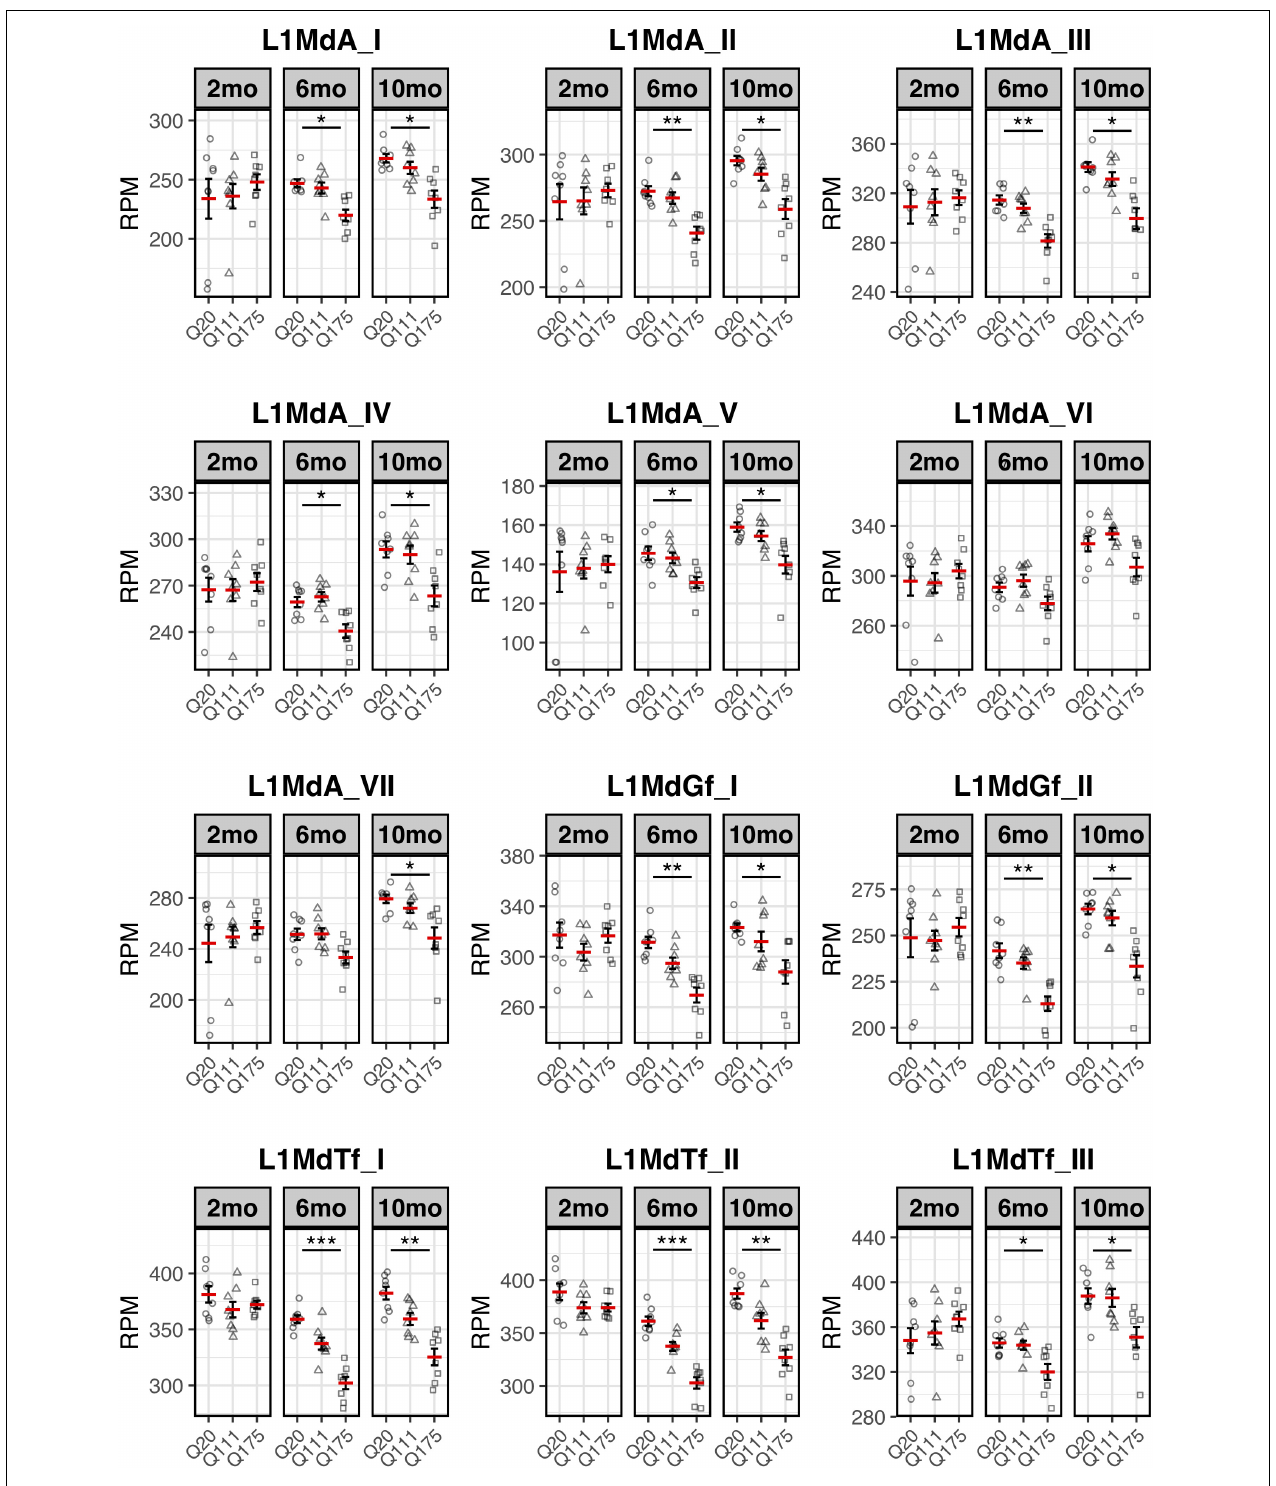
FIGURE 2 | Expression of the 7 L1-A (L1MdA), 2 L1-Gf (L1MdGf), and 3 L1-Tf (L1MdTf) in the mouse striatum. L1 expression is reported as number of mapped reads normalized on the total number of reads of each sample (RPM) for Q20 (control) (circle), Q111 (triangle) and Q175 (square) in 2-month-old mice (2 mo—left panel), 6-month-old mice (6 mo—middle panel), and 10-month-old mice (10 mo—right panel). Horizontal red segment represents mean, error bars report mean ± sem (standard error of the mean). *FDR < 0.05, **FDR < 0.01, ***FDR < 0.001. Each group is composed by 8 biological replicates ( n = 8).